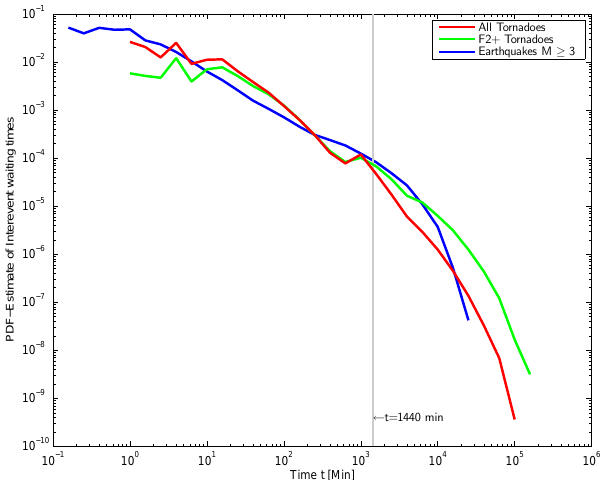
Fig. 1. Gutenberg–Richter law: Comparison of probability density distributions of tornadoes (1950–2006, USA, red curve) and earth- quakes (1981–2000, SCSN catalogue, blue curve) concerning their moments: atmospheric moments M a and seismic moments M 0 . Lin- ear fits have been applied to the double-logarithmic plot of the data (black solid line for tornadoes, black dashed line for earthquakes) with slopes of − 1 . 19 for tornadoes and − 1 . 80 for earthquakes.